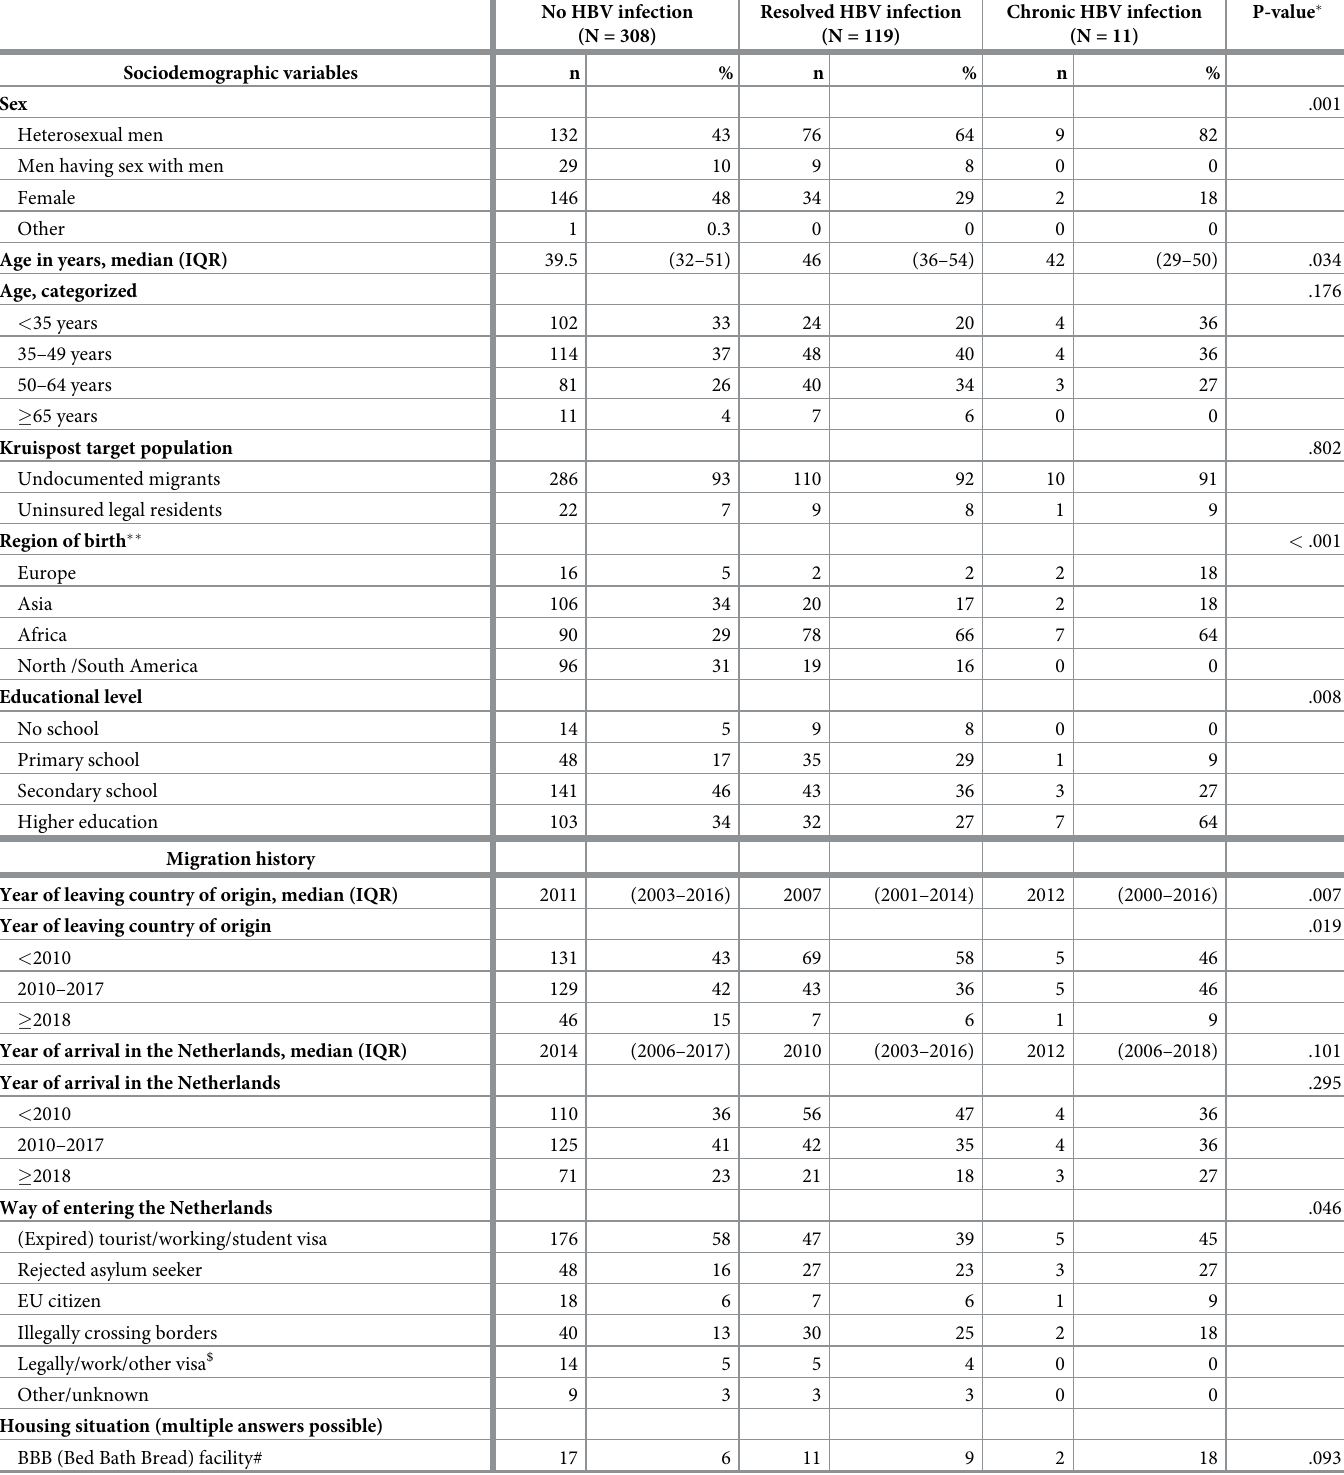
Table 3. Characteristics of undocumented migrants and uninsured legal residents tested for HBV (N = 438) by HBV status, in Amsterdam, the Netherlands, Octo- ber 2018- October